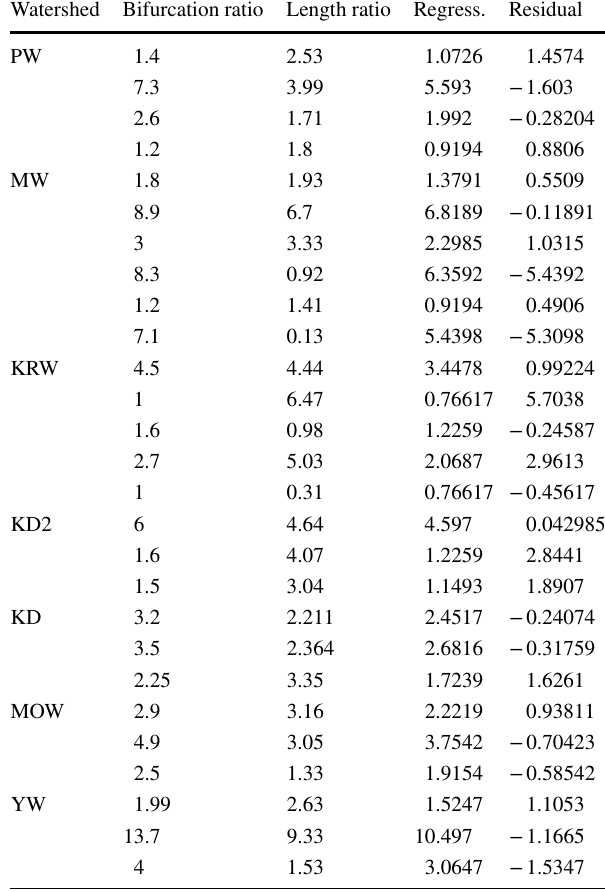
Table 3 RMA regression: bifurcation ratio-length ratio Watershed Bifurcation ratio Length ratio Regress.